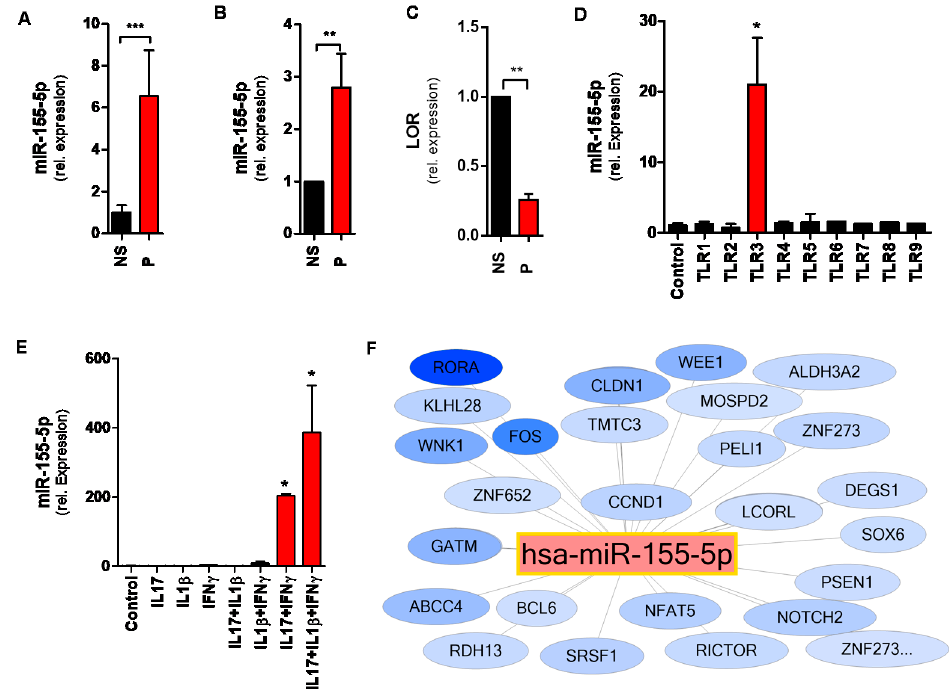
Figure 7. miR-155 is induced by inflammatory cytokines and TLR3 activation. ( A ) miR-155 expression is upregulated in psoriasis lesions (P) compared to normal skin (NS) based on our PCR analysis; n =4. ( B ) Validation data from the Genevestigator platform using expression values from five independent studies. ( C ) PCR analysis reveals significant downregulation of loricrin in psoriasis lesions (P) compared to normal skin (NS); n =3. ( D ) Stimulation of TLR3 induced miR-155 expression in vitro, while other TLRs did not affect miR-155 expression; n = 3. ( E ) The combination of IL17 and INF γ